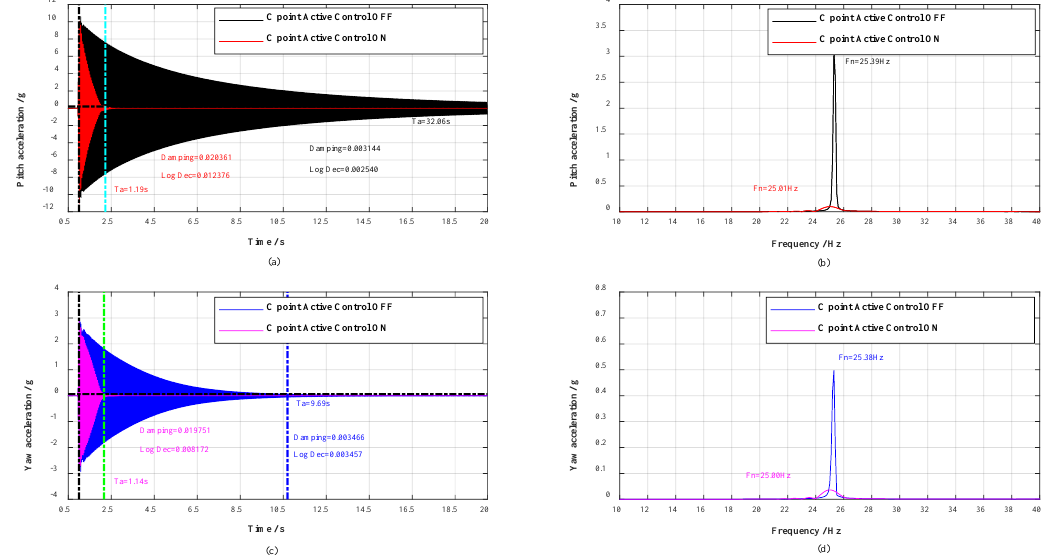
Figure 8. Response spectral analysis. Control effect during impulse tests in any plane (C point).